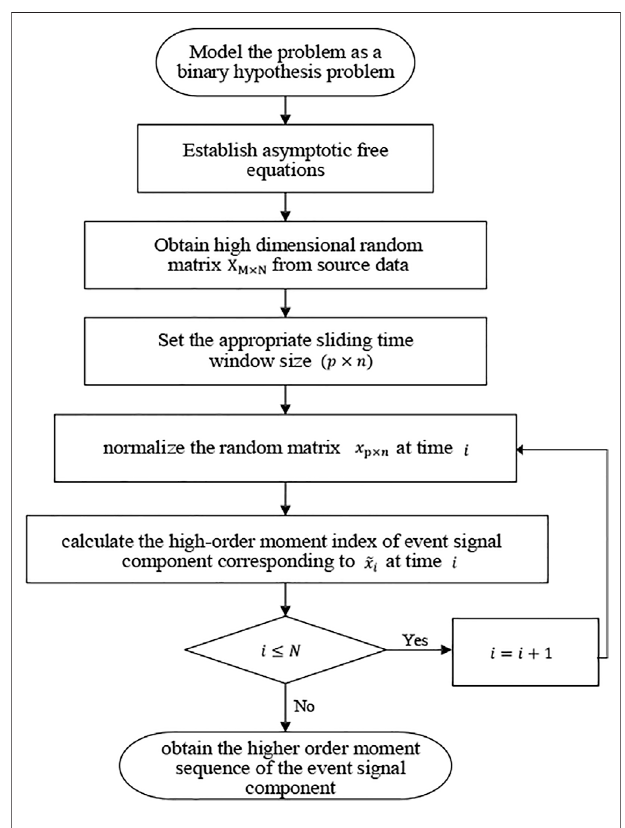
FIGURE 1 | Distribution network status evaluation process based on